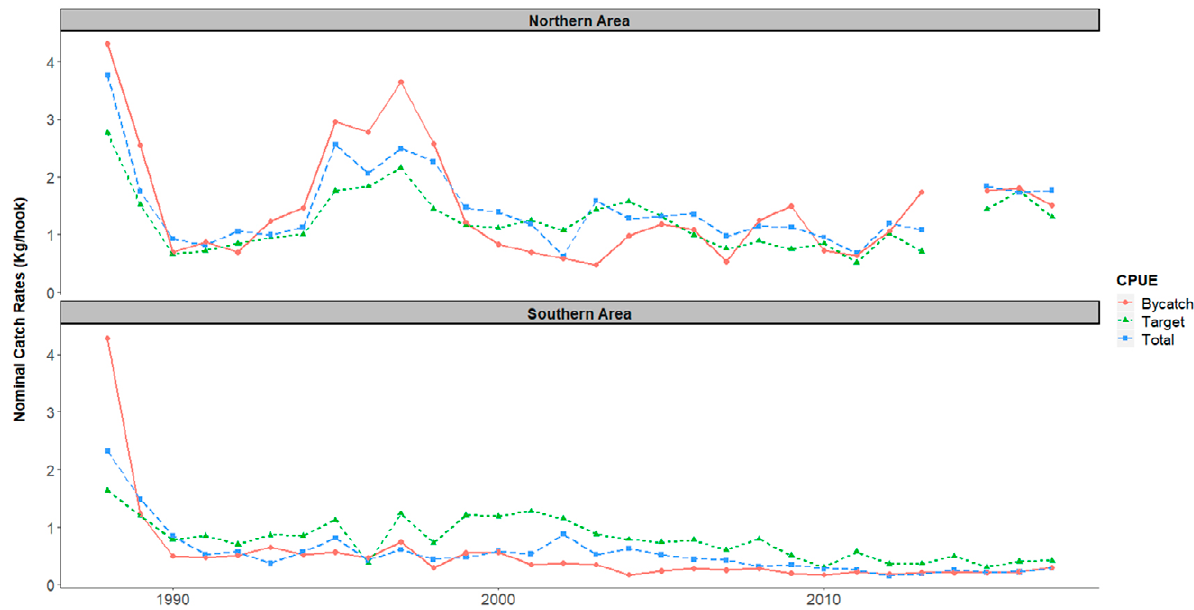
Fig. 7. – Nominal catch rates in the clusters in which pink cusk-eel is caught as targeted (variable clustering per year), total (without fishing tactic) or by-catch. Scenario 2, variable fishing